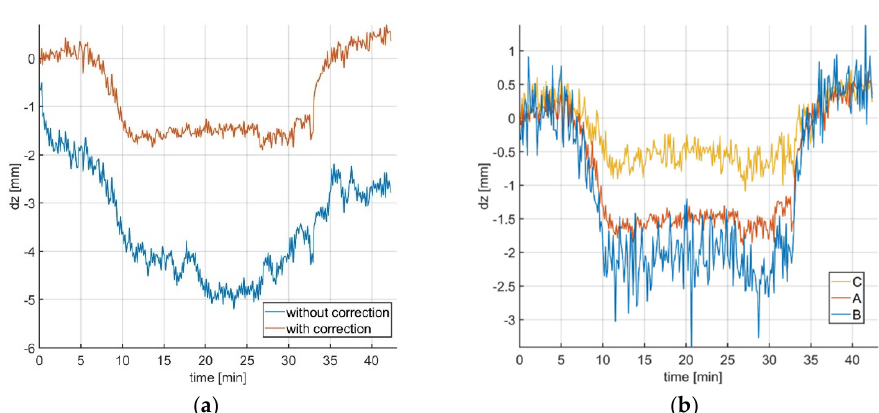
Figure 17. Vertical component of displacement during time: ( a ) comparison between vertical displacement with and without atmospheric correction; ( b ) comparison between three points at the same distance located on the right, on the center, and on the left of the carriage.